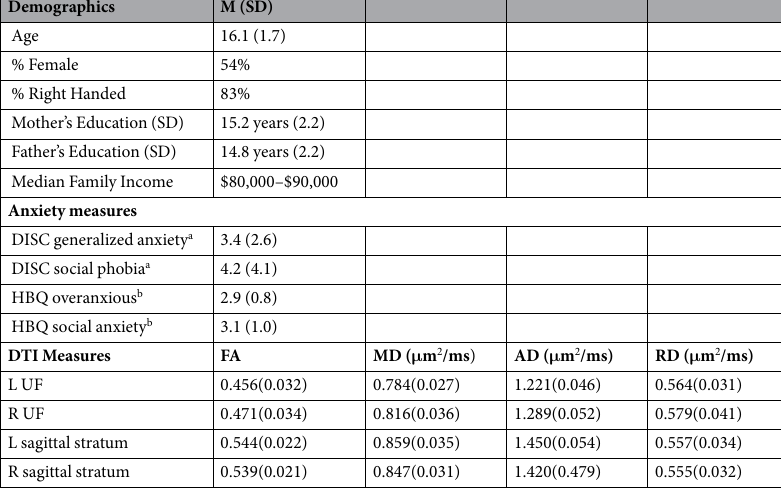
Table 1. Demographic characterization of the sample, and mean levels of study variables. a Symptom counts from the Diagnostic Interview Schedule for Children-IV. b Likert rating (1–6) from the Health and Behavior